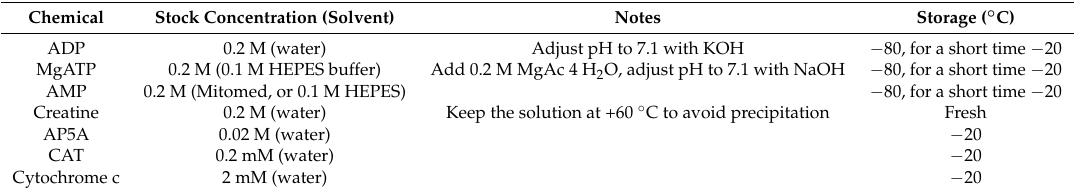
Table 1. Selected chemicals used in high-resolution respirometry experimental protocols to study creatine kinase and adenylate kinase energy-transfer